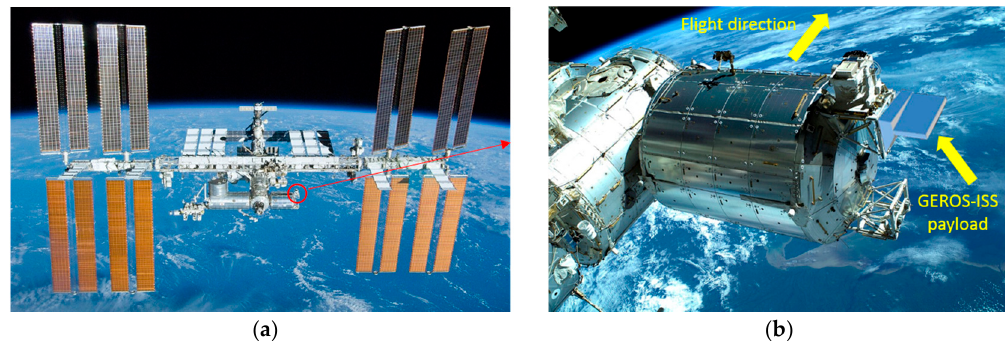
Figure 1. ( a ) View of the International Space Station, and ( b ) view of the Columbus module that will host GEROS-ISS payload in the upper